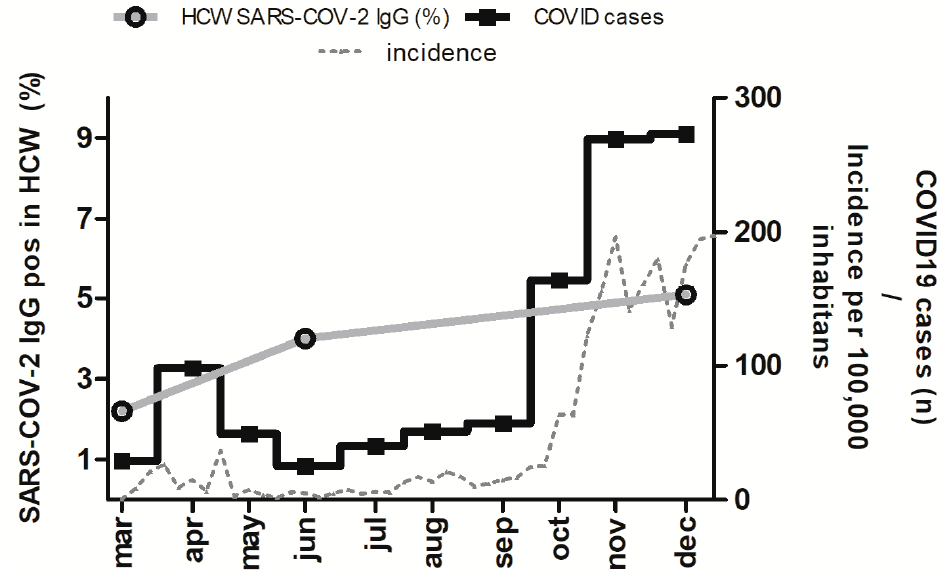
Figure 1. Frequency of healthcare workers testing positive for SARS-COV-2 IgG (grey); the COVID19 cases (black) treated at the University Hospital Essen; the COVID-19 incidence per 100,000 inhabitants in the Essen district from March 2020 (week 10) to December 2020 (week 53). The data of the COVID-19 incidence in the district of Essen are publicly available from the Survstat@RKI 2.0 server. Robert Koch-Institut: SurvStat@RKI 2.0, https://survstat.rki.de, accessed on: 22 February 2021.